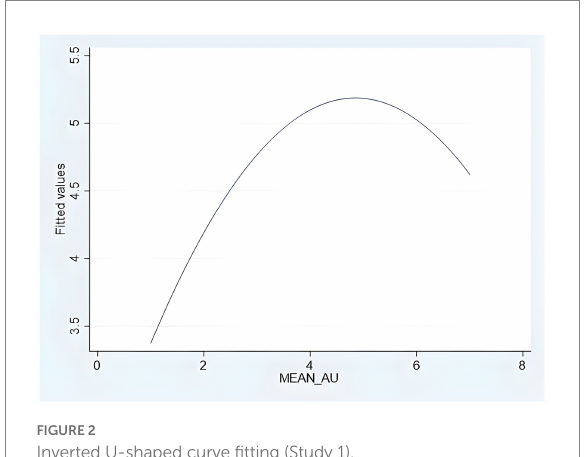
FIGURE 2 Inverted U-shaped curve fitting (Study